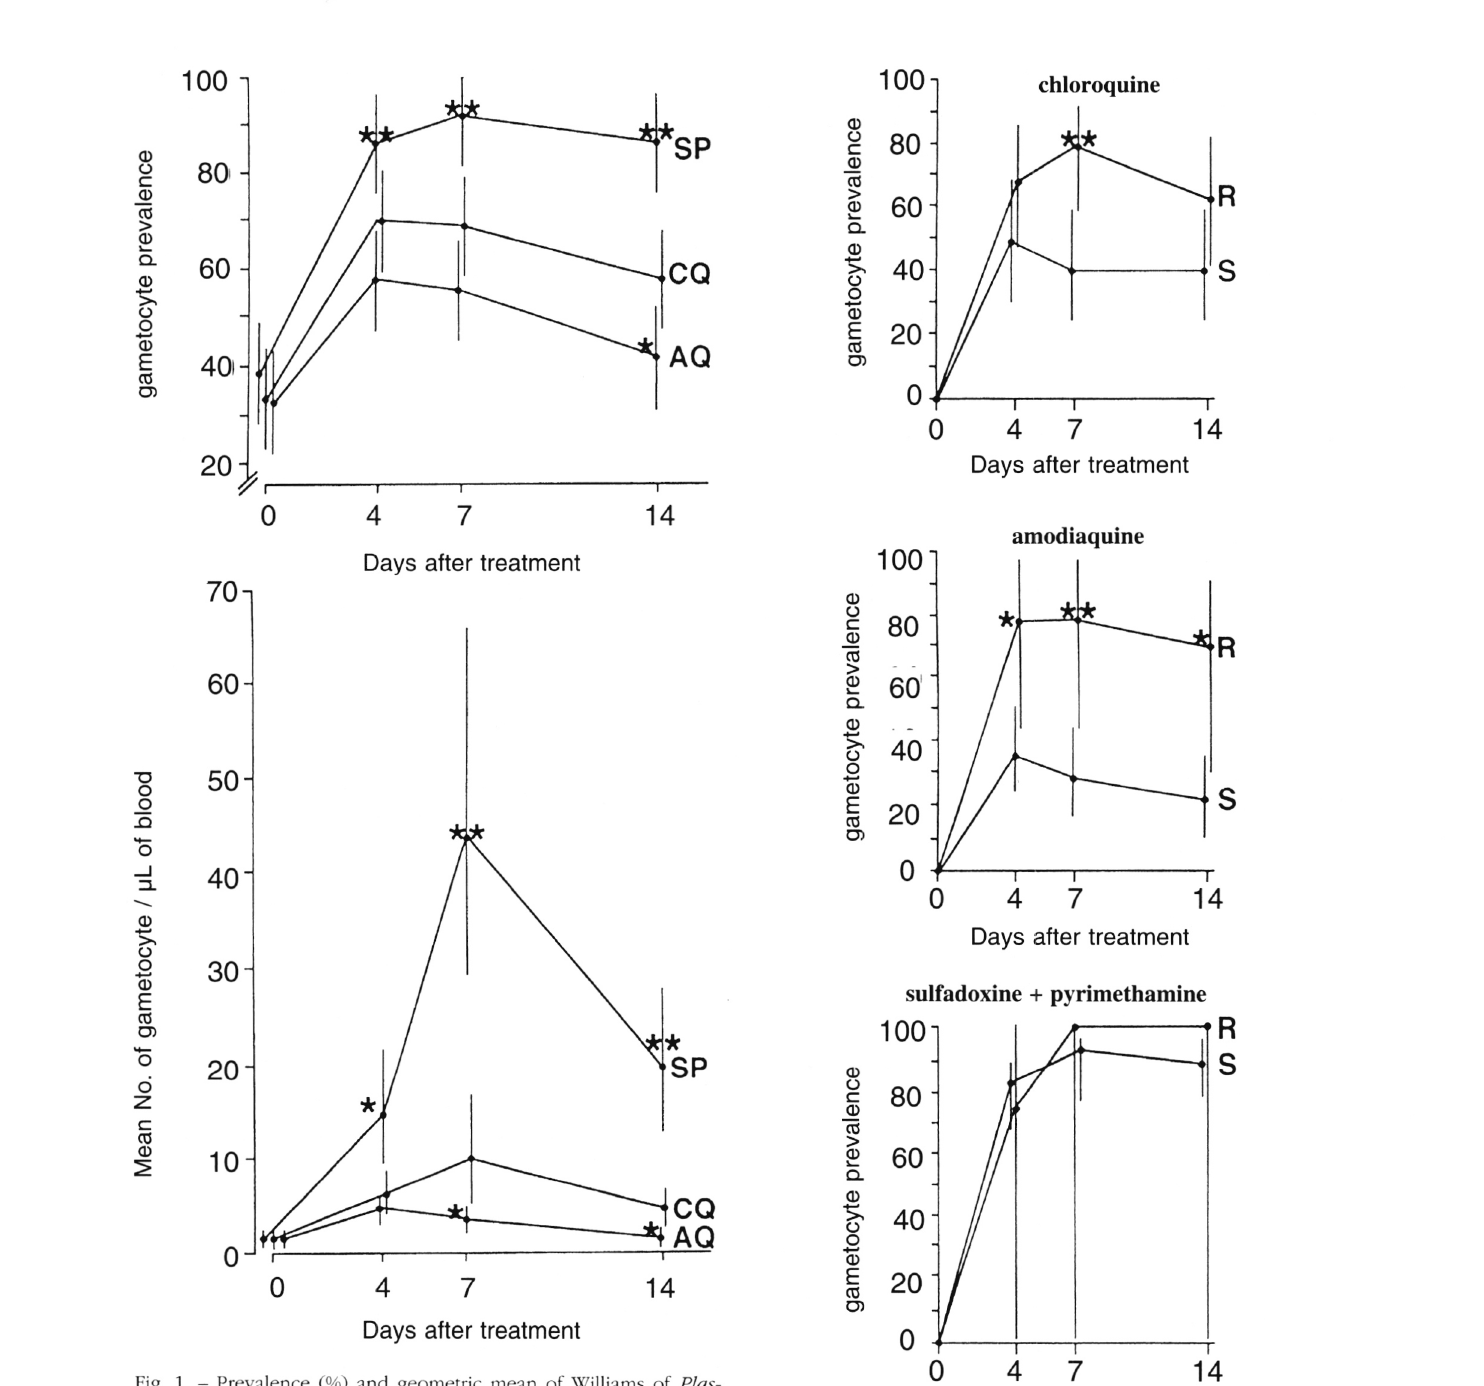
Fig. 1. - Prevalence (%) and geometric mean of Williams of Plas­ modium falciparum gametocytes for patients in simple malaria access treated with different drugs (8 patients with chloroquine CQ, 87 patients with amodiaquine AQ, and 95 patients with sulfadoxine plus pyrimethamine SP). Above spots of AQ and SP curves, one aste­ risk indicates a P value < 0.05 and two asterisks indicate a P value < 0.005, by comparing against CQ on the same day with Fisher’s exact test (prevalence) or Mann-Whitney U- test (density). Bars indi­ cate the 95 % confidence interval.